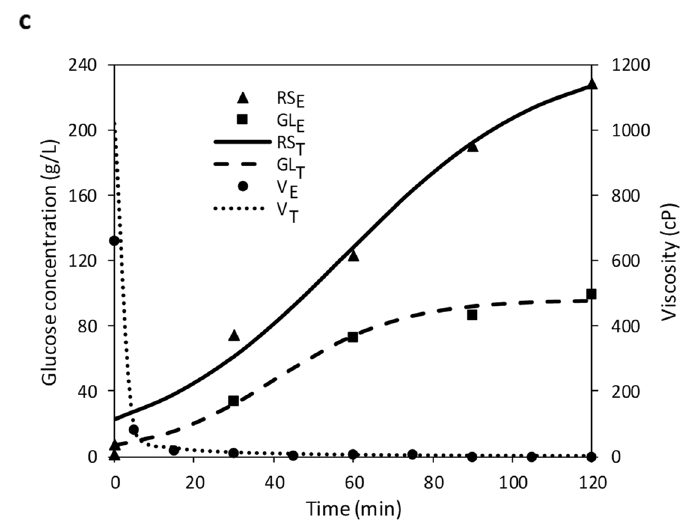
Figure 1. ( a ) Evolution of experimental and theoretical reducing sugar concentration (RS E and RS T , respectively) and viscosity curve (V E and V T ) during liquefaction of trial No. 16. ( b ) Evolution of experimental and theoretical glucose concentration (GL E and GL T ) during saccharification of trial No. 16. ( c ) Evolution of RS E , RS T , GL E , GL T and V T and V E during simultaneous hydrolysis of the trial No. 16. Table 3. Optimal pH and temperature for each response in the sequential and simultaneous enzymatic